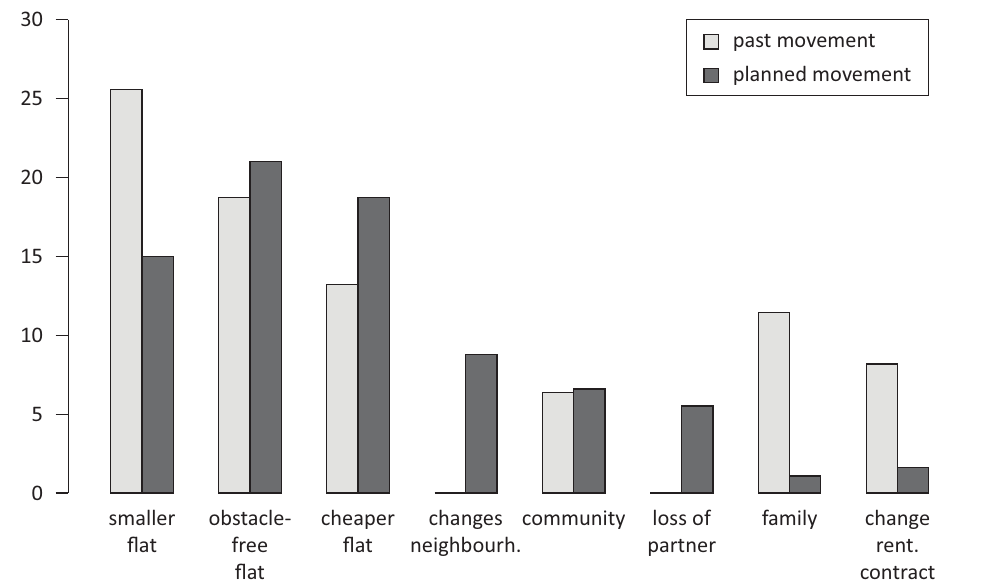
Figure 3. Main reasons for movement (% of respective movement type (past or planned), multiple answers possible). tion of movement. While earlier studies tend to focus on movements to nursing homes and assisted living apart- ments (e.g., Nay, 1995; Taylor, Osterman, Will Acuff, & (or planned to move) into apartments with lower